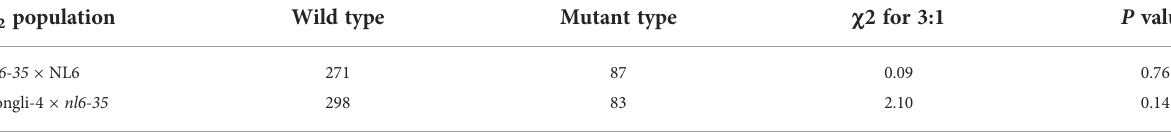
TABLE 1 Phenotypic segregation in the F 2 population of nl6-35 × NL6 and Longli-4 × nl6-35 . F population 2